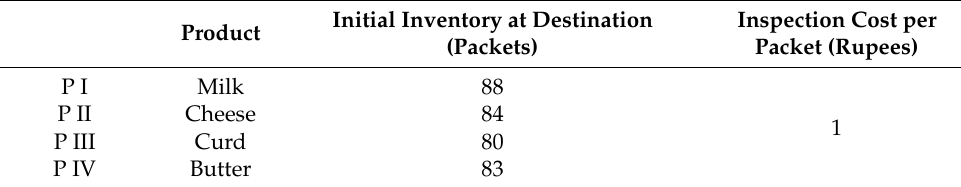
Table A2. Initial quantity and inspection cost per packet of four products at retailers.